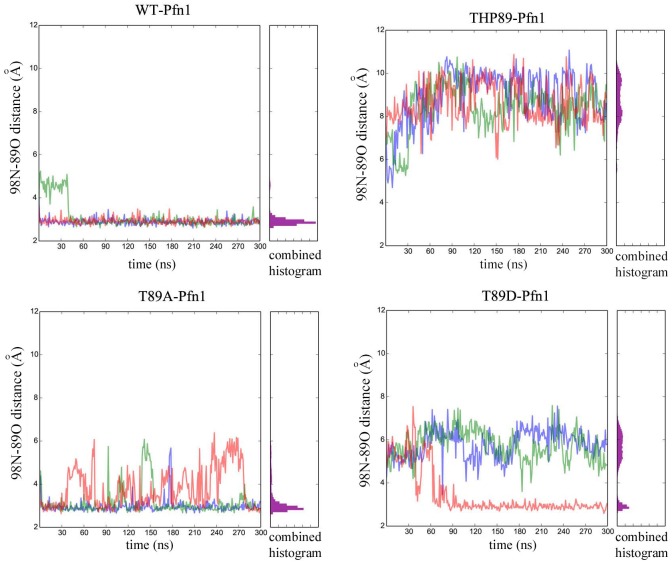
Molecular Dynamics Simulation predicting the effect of T89 phosphorylation on the stability of intramolecular 98N-89O bond.The stability of this intramolecular 98N-89O bond over the course of three 300ns molecular dynamics simulations of monomeric Pfn1 are shown for homology models based on the bound structure for WT, T89A, T89D and phosphorylated T89 (THP89) variants of Pfn1 (each color represents an individual simulation). The histograms alongside the line graphs summarize the results of all three simulations for each variant of Pfn1.